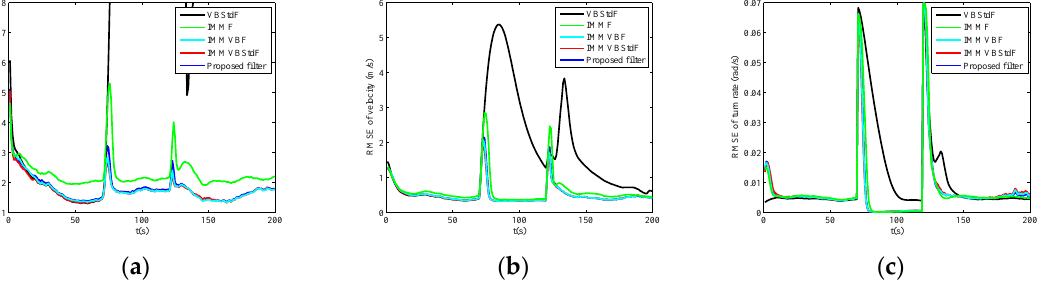
Figure 2. Root mean square errors (RMSEs) versus time in Case A. ( a ) Position; ( b ) Velocity; ( c ) Turn rate.